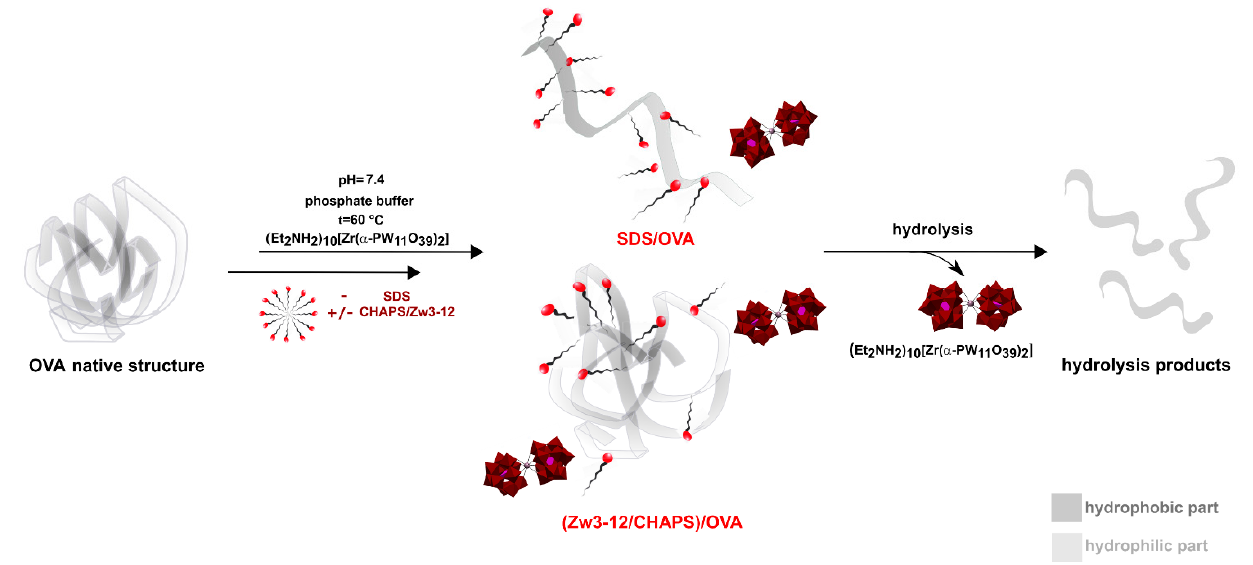
Figure 8. Schematic representation of the interaction between OVA and Zr(IV)-substituted Keggin-type POM, (Et 2 NH 2 ) 10 [Zr( α -PW 11 O 39 ) 2 ] (Zr-K 1:2) in the presence and absence of different surfactants.